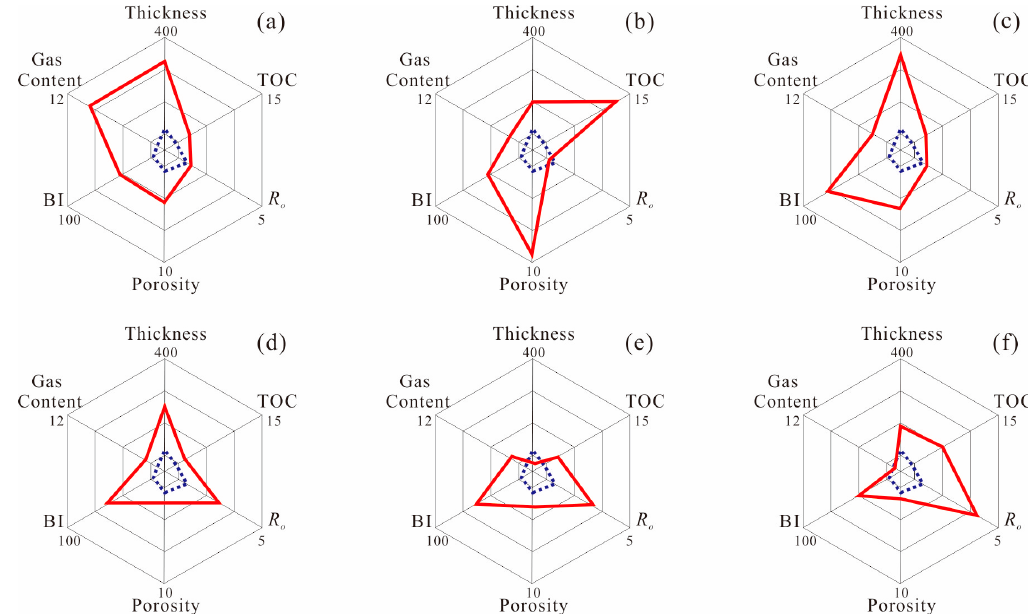
Figure 12. Comparison of reservoir properties among the different marine shales. ( a ) Barnett shale; ( b ) New Albany shale; ( c ) Ohio shale; ( d ) LSL shale; ( e ) UOW shale and ( f ) LCN shale. ( a – d ) are modified from Curtis [44]. The dotted lines represent the minimal threshold for shale gas development [43].